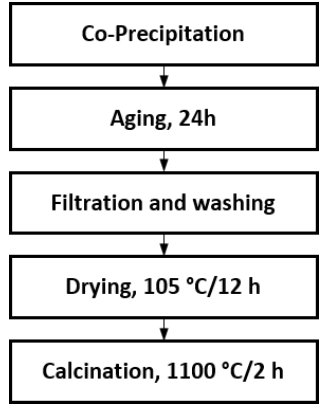
Figure 1. Co-precipitation method flowchart. Table 1. Sample code and preparation method.